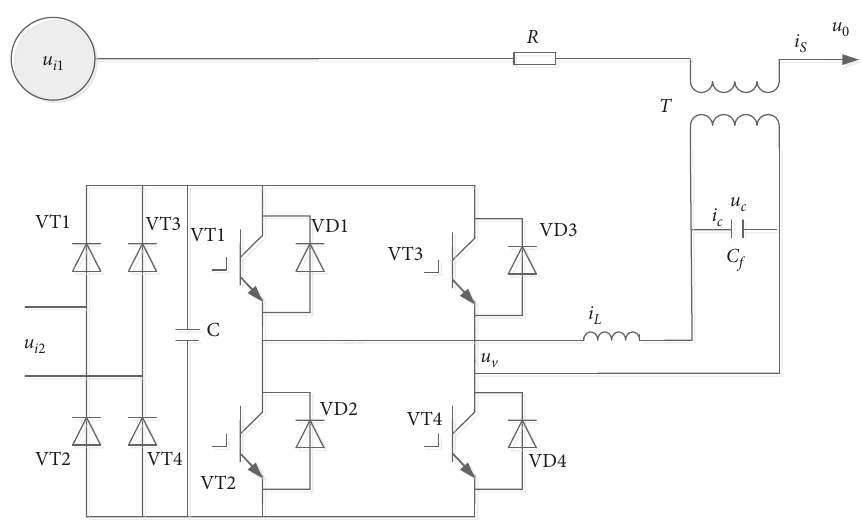
Figure 1: DVR system circuit